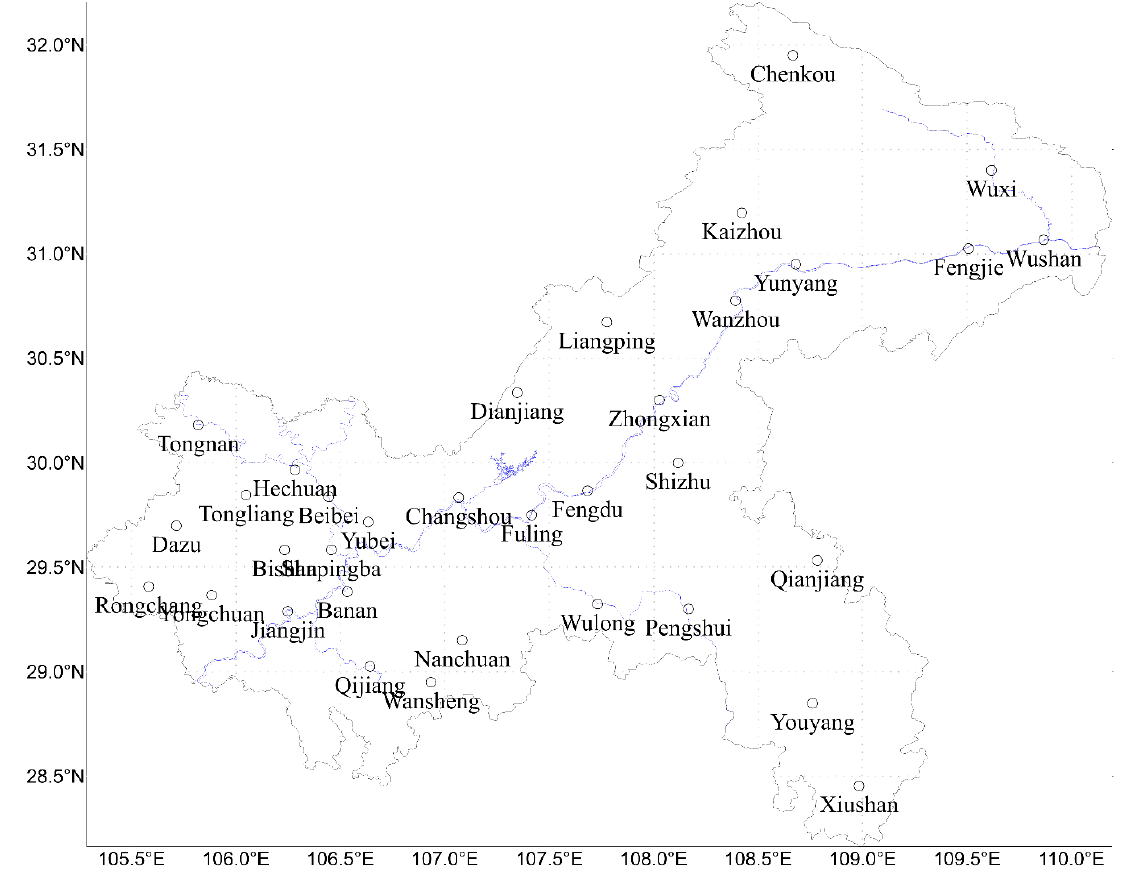
Figure 1. Map of 34 national meteorological stations in Chongqing.